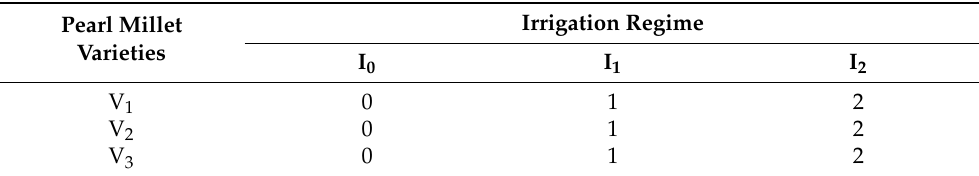
Table 4. Treatments in 2016, 2017 and 2017/2018 varieties (V 1 , V 2 , V 3 ) and water irrigation regimes (I 0 , I 1 , I 2 ). Irrigation Regime Pearl Millet Varieties I 0 I 1 I 2 V 1 0 1 2 V 2 0 1 2 V 3 0 1